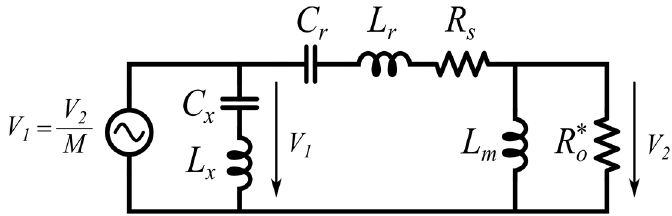
Figure 17. FHA equivalent circuit with auxiliary circuit.